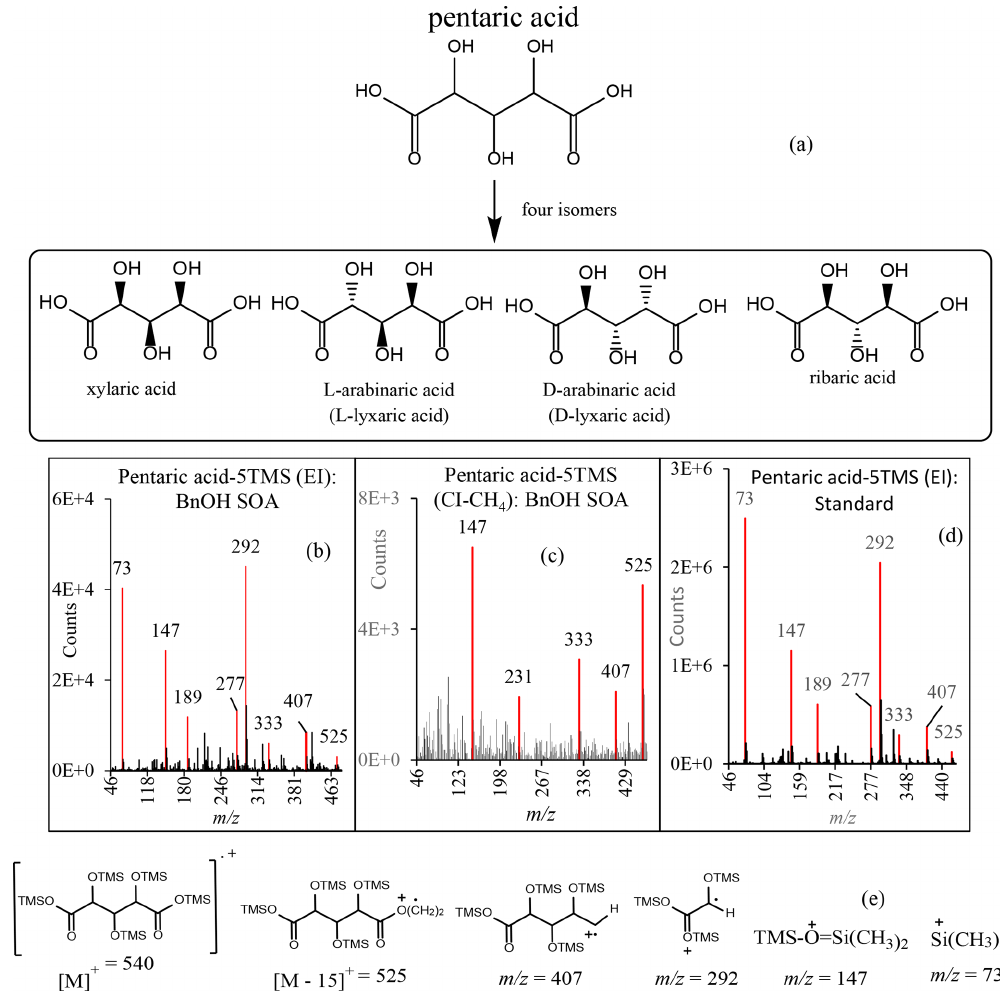
Figure 6. Molecular structures of pentaric acid and its isomers (a) ; mass spectra of TMS derivatives of pentaric acid acquired for smog chamber SOA (EI: b , CI: c ) and an authentic standard ( d : EI); major pentaric acid fragments observed in EI mode (e)